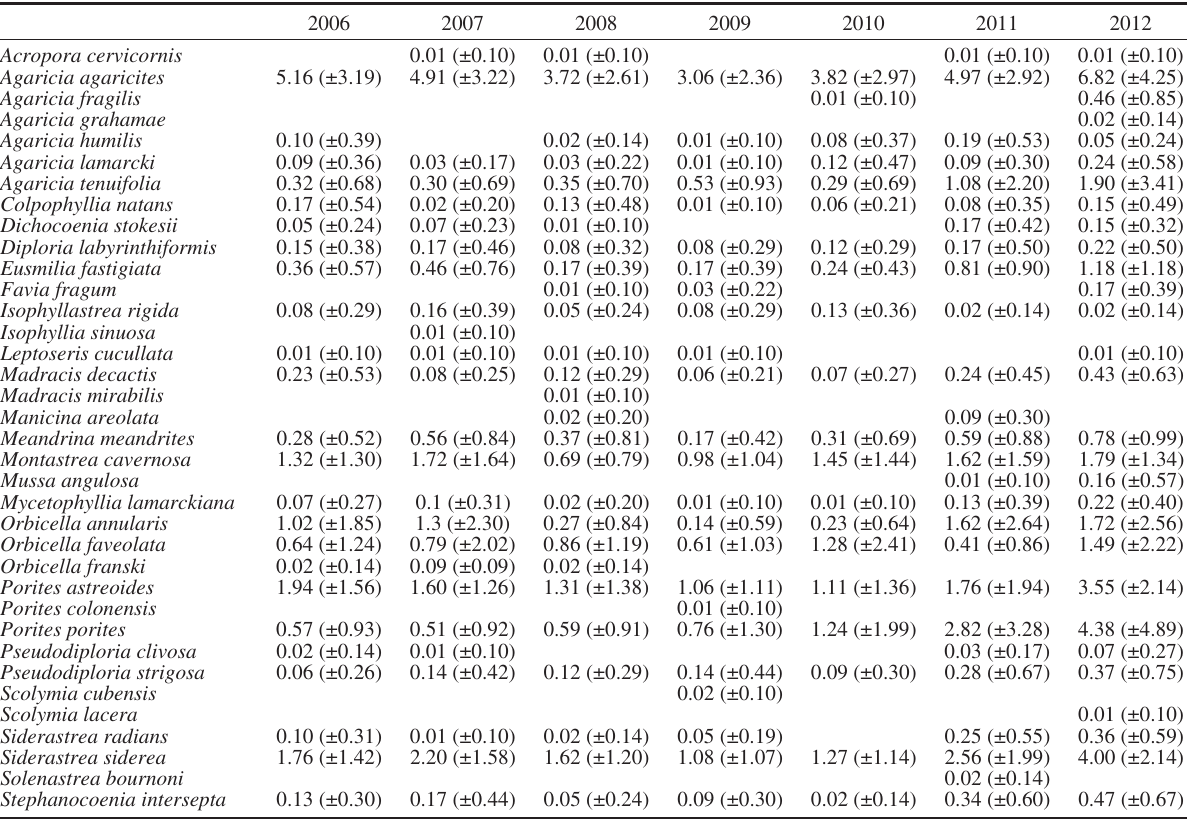
Table S2. – Mean coral cover (±1SD) of the species recorded in the Cozumel National